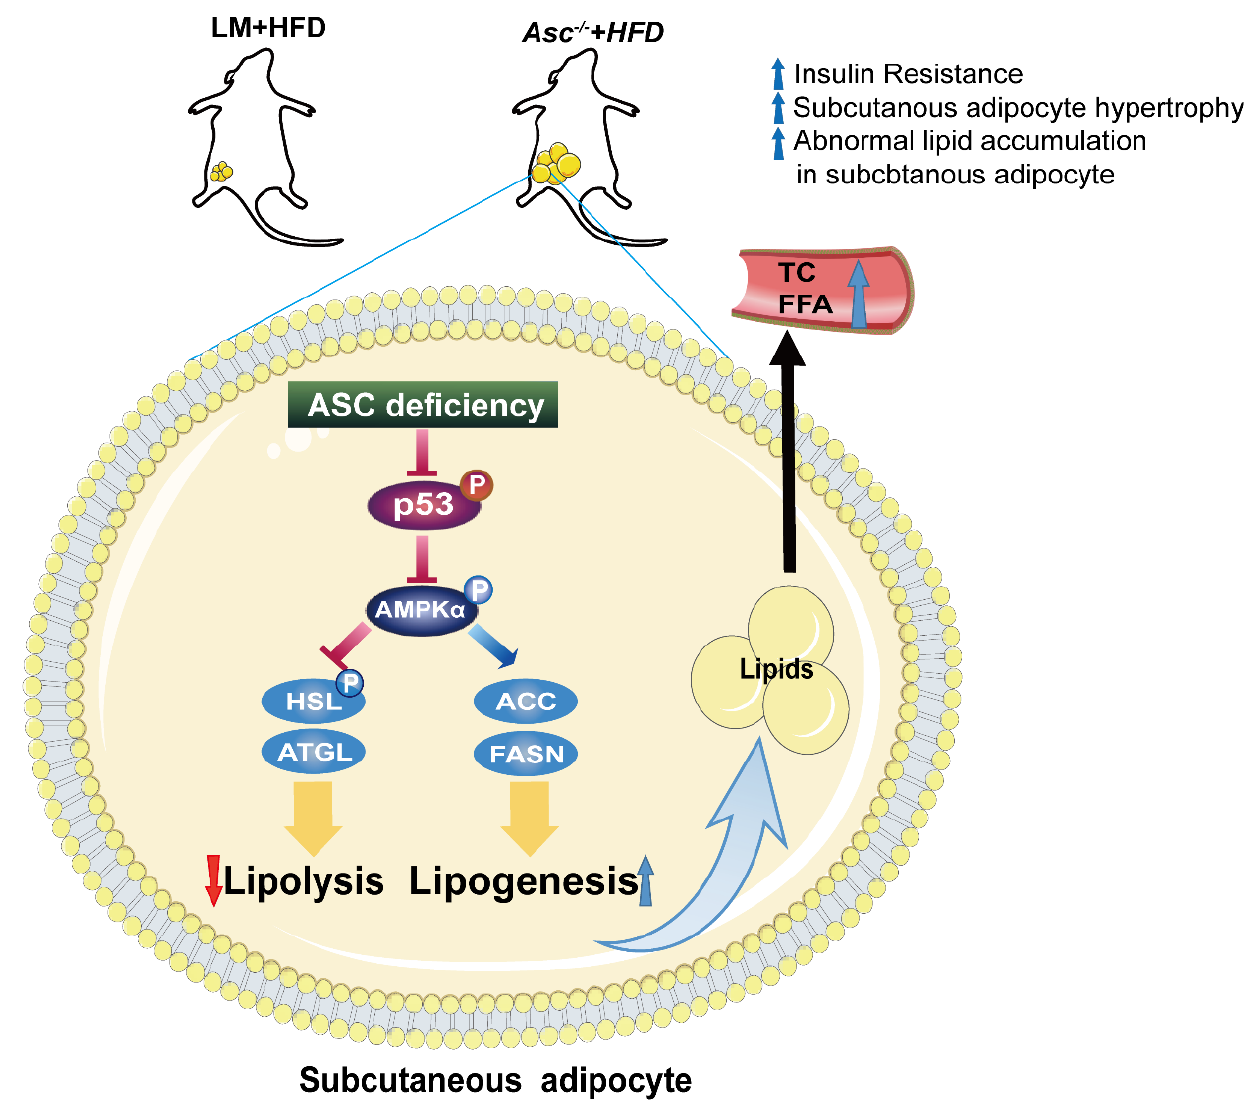
Figure 5. The proposed model for the mechanism by which ASC deficiency promotes lipid accu- mulation. A summary of our findings: ASC deficiency in SAT leads to decreased p53 expression, reducing AMPK α phosphorylation and lessening active AMPK α levels. ASC deficiency promotes lipogenesis, inhibits lipolysis, and causes increased subcutaneous adipocyte lipid accumulation, abnormal metabolism, and obesity.